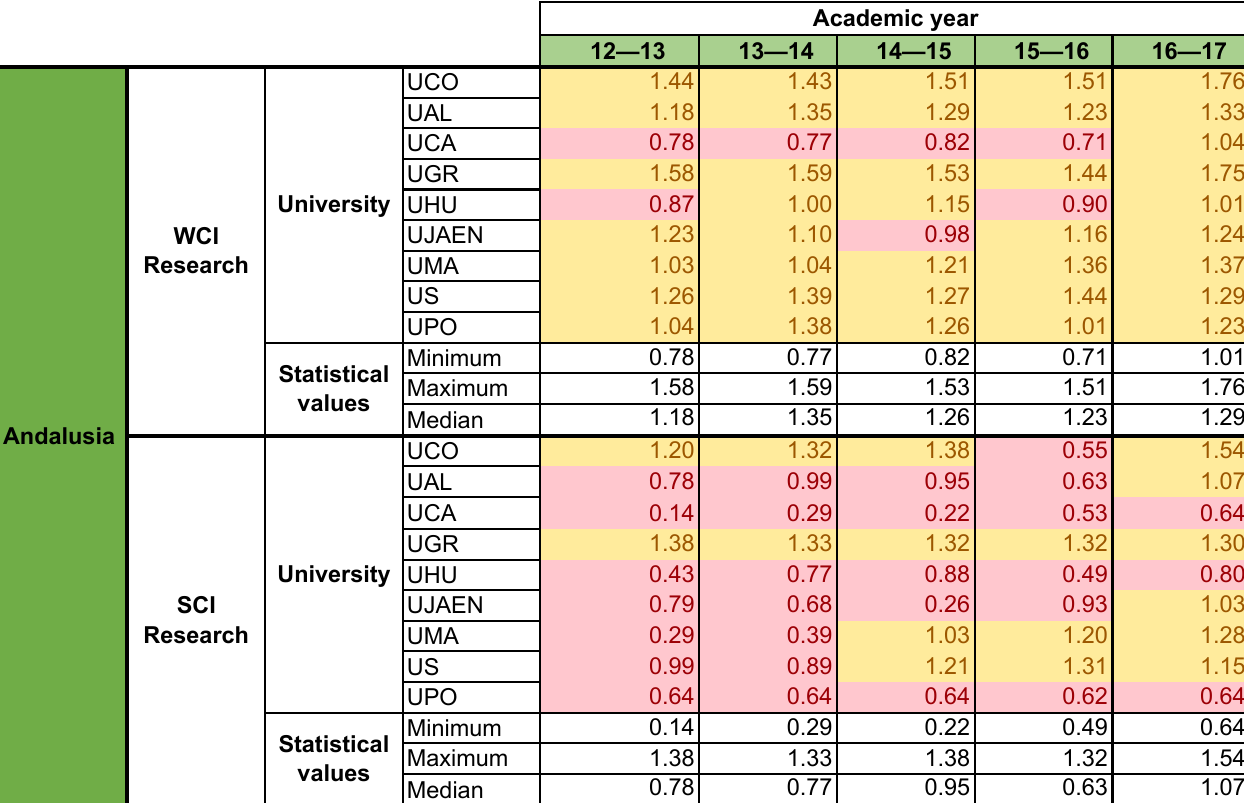
Figure A8. WCI and SCI values of the Madrid public universities in their teaching mission.